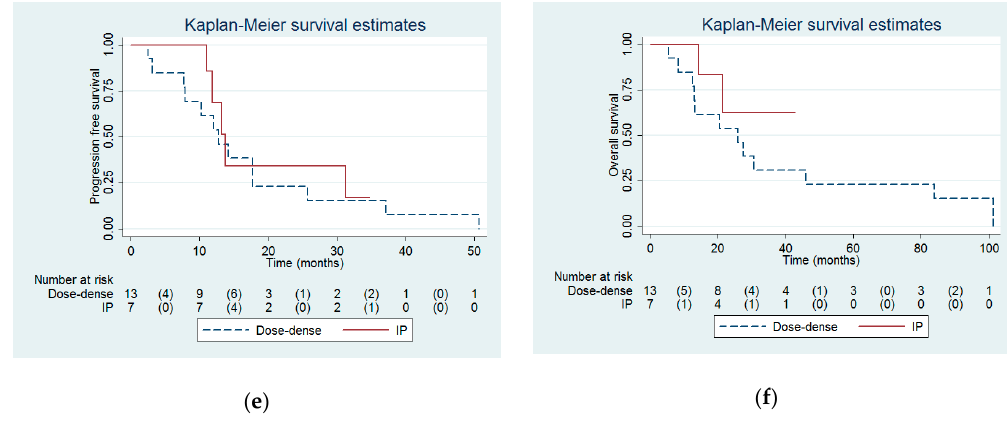
Figure 1. Probabilities of ( a ) progression free survival and ( b ) overall survival between the intraperitoneal (IP) and dose-dense groups in all enrolled women ( n = 50). Probabilities of ( c ) progression free survival and ( d ) overall survival between the IP and dose-dense groups in optimally debulked women ( n = 25). Probabilities of ( e ) progression free survival and ( f ) overall survival between the IP and dose-dense groups in sub-optimally debulked women ( n = 25). Multivariable Cox proportional-hazards model revealed that IP chemotherapy was the only independent predictor of PFS (hazard ratio = 0.38, 95% confidence interval (CI) = 0.16 to 0.90, p = 0.03, Table 2). Table 2. Cox proportional-hazards model to predict progression free survival ( n = 50). Univariate Multivariable Variable Hazard Ratio 95% CI † p Hazard Ratio 95% CI ‡ p Regimen (IP = 1 vs. dose-dense = 0) 0.47